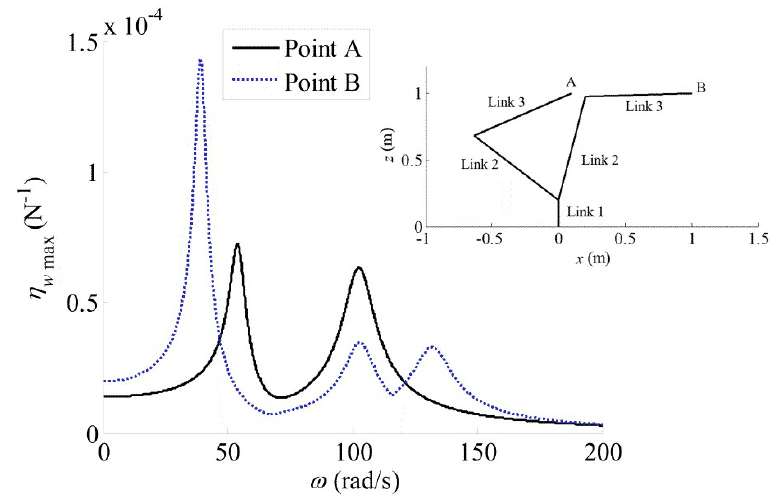
ff erent force and torque frequencies at two Figure 5. η wmax with different force and torque frequencies at two points. Figure 5. η wmax with di